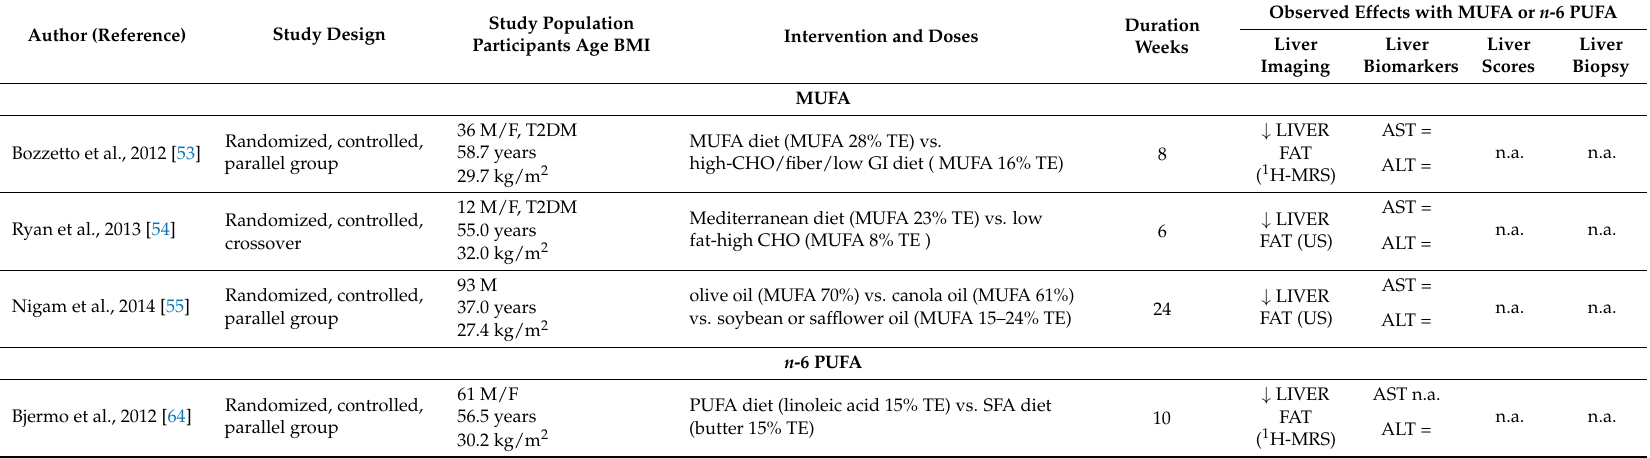
Table 1. Clinical trials on the effects of MUFA and n -6 PUFA on NAFLD in individuals at high cardiometabolic